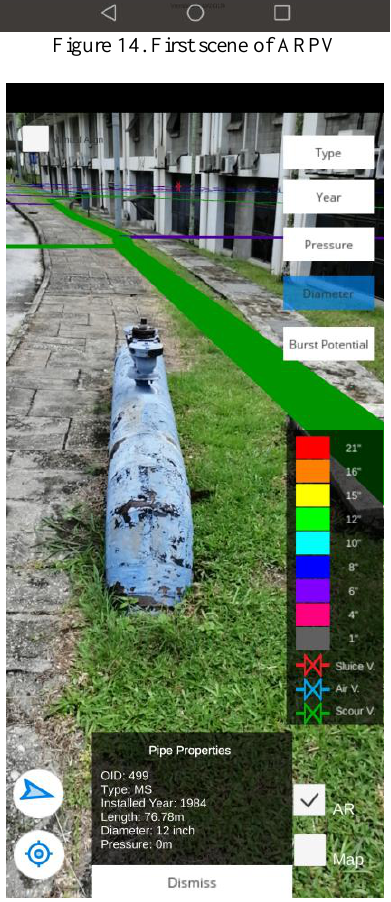
Figure 15. AR view of